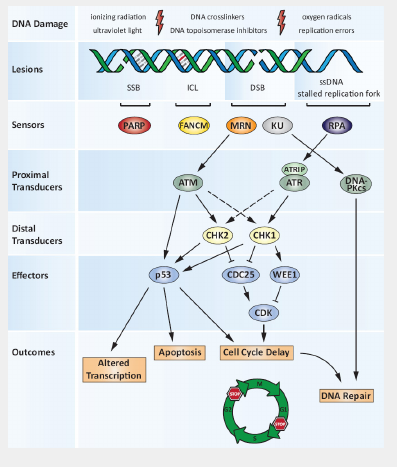
The DNA damage response. Exogenous and endogenous DNA damaging agents generate various types of lesions including DNA single- and double-strand breaks (SSBs and DSBs). The multifunctional MRN complex detects DSBs, while FANCM is required for the DNA interstrand crosslink (ICL)-induced checkpoint response. PARP predominantly acts as a SSB sensor protein. RPA binds to regions of single-stranded DNA (ssDNA) that are exposed at stalled replication forks or after DSB resection. MRN and RPA mediate the recruitment of ATM and ATR-ATRIP, respectively, and the subsequent activation of the respective pathways, coordinating cell-cycle checkpoints, DNA repair and apoptotic responses to DNA damage. The Ku70/Ku80 heterodimer (KU) competes with MRN for binding to DSBs. KU recruits DNA-PKcs to form the catalytically active DNA-PK holoenzyme which is a major component of the canonical NHEJ machinery during DSB repair. MRN on the other hand initiates HR (see also fig. 2). Once activated, the DNA damage signalling cascade extends through multiple phosphorylation events primarily via the cell-cycle checkpoint kinases CHK1 and CHK2. Their signals converge on downstream effectors such as the tumour suppressor protein p53 or the CDC25 protein phosphatase and WEE1 tyrosine kinase. As a result, CDK activity is inhibited, delaying cell cycle progression from G1 to S (the G1/S checkpoint) or from G2 to M phase (the G2/M checkpoint). The DNA damage response (DDR) thus orchestrates a variety of cellular outcomes: the transcriptional programme of the damaged cell is altered and the cell cycle is transiently arrested, thereby facilitating repair of the DNA lesions. In situations where DNA damage is too severe and cannot